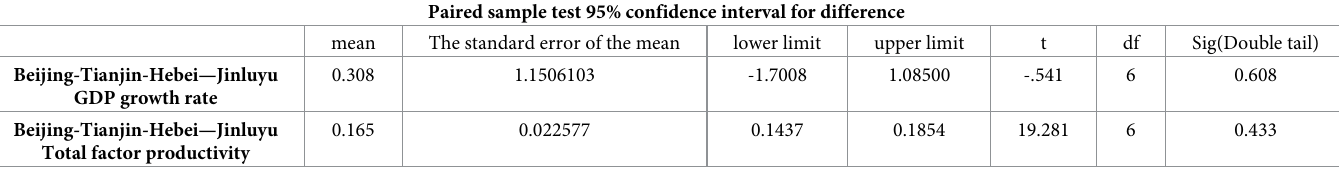
Table 2. Paired sample T